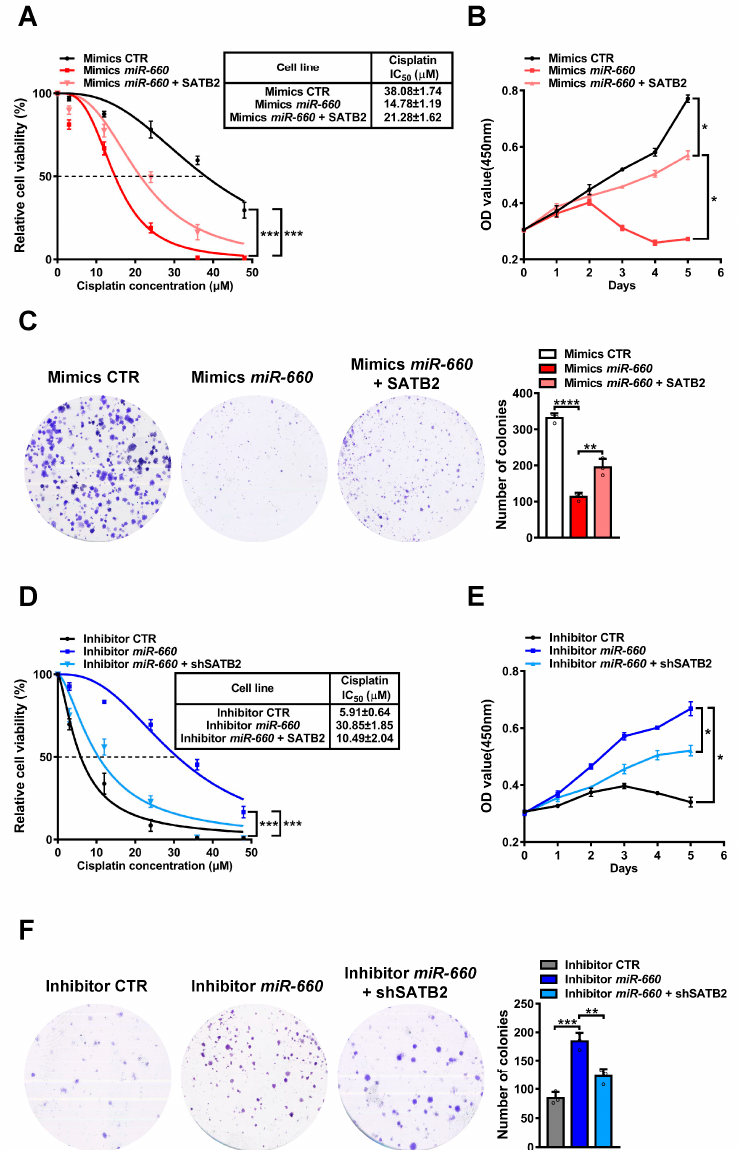
Figure 5. MiR - 660 regulates cisplatin sensitivity in LUAD cells through SATB2. ( A ) Comparison of cisplatin IC 50 values between mimics CTR, miR - 660 mimics, and miR - 660 mimics + SATB2 in A549/CDDP cells. ( B , C ) With cisplatin treatment, the capacities of cell proliferation and colony formation of A549/CDDP cells in mimics CTR, miR - 660 mimics, and miR-660 mimics + SATB2 groups were examined using CCK8 and colony formation assays. ( D ) Comparison of cisplatin IC 50 values between inhibitor CTR, miR - 660 inhibitor, and miR - 660 inhibitor + shSATB2 in A549 cells. ( E , F ) With cisplatin treatment, the capacities of cell proliferation and colony formation of A549 cells in inhibitor CTR, miR - 660 inhibitor, and miR - 660 inhibitor + shSATB2 groups were examined using CCK8 and colony formation assays. Data are presented as the mean ± standard deviation. * p < 0.05, ** p < 0.01, *** p < 0.001, **** p < 0.0001.